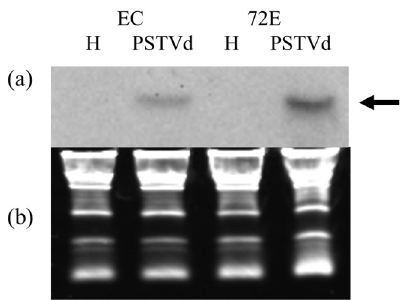
Figure 7. Northern-blot hybridization of miR398a-3p. Aliquots (10 μg) of total RNA, isolated at 3 wpi, were fractionated by electrophoresis in 8M-urea 12% PAGE, transferred to nylon membrane, and hybridized with a DIG-labeled cRNA probe for miR398a-3p. ( a ) Band signals were visualized with ChemiDoc XAR (BioRad) and quantified with Quantity One software (Bio-Rad). MiR398a-3p was detectable only after PSTVd infection (arrow), and signal intensities were approximately five-times higher in line 72E as compared to a control line EC. ( b ) The loading control stained with ethidium bromide. This analysis was repeated